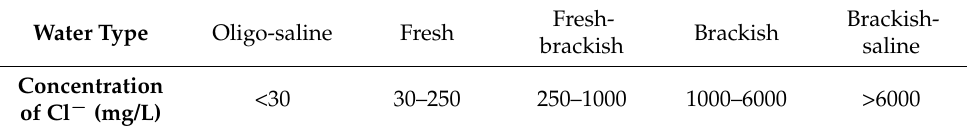
Table 5. Modified classification of water types according to the concentration of Cl − (mg/L) [28].